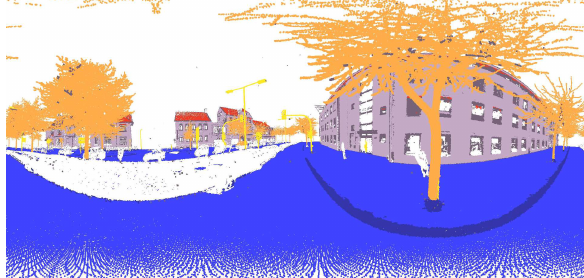
Figure 4. Final classification. Panoramic rendering of the classified point cloud.